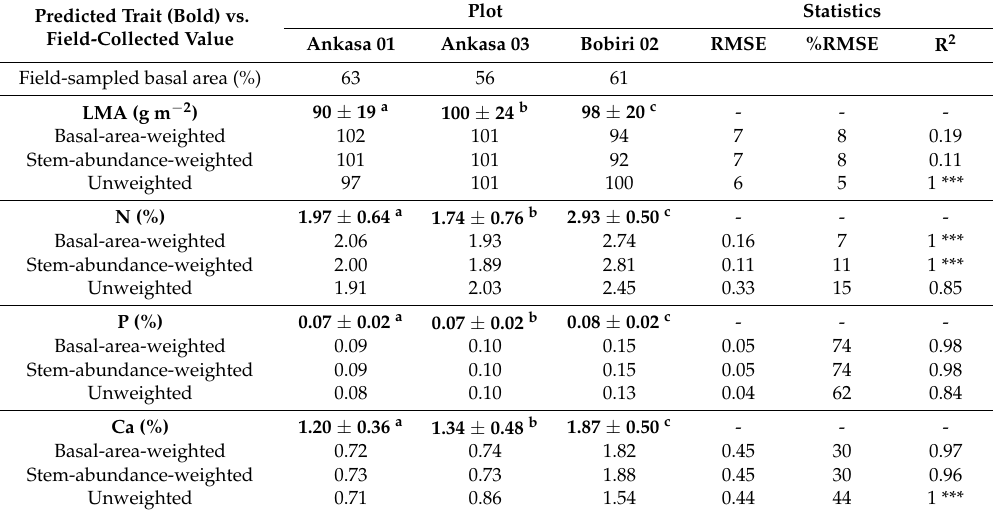
Table 3. Average predicted foliar traits (bold) for three one-ha tropical forest plots. Calculated using UAV-collected hyperspectral data and PLSR analysis. Field-collected trait values are shown for comparison purposes. The field-collected data have been weighted using three methods: basal-area-weighting, stem-abundance-weighting and no weighting. The root mean square error (RMSE), percentage root mean square error (%RMSE) and r 2 values of predicted vs. field-collected traits are shown for each method of weighting. ( n = 3). The level of significance ( p ) is indicated (* p < 0.10; ** p < 0.05; *** p < 0.01). Significant differences ( p < 0.01) between the predicted trait values of each plot are denoted using the letters a–c Where necessary, values have been rounded to two decimal